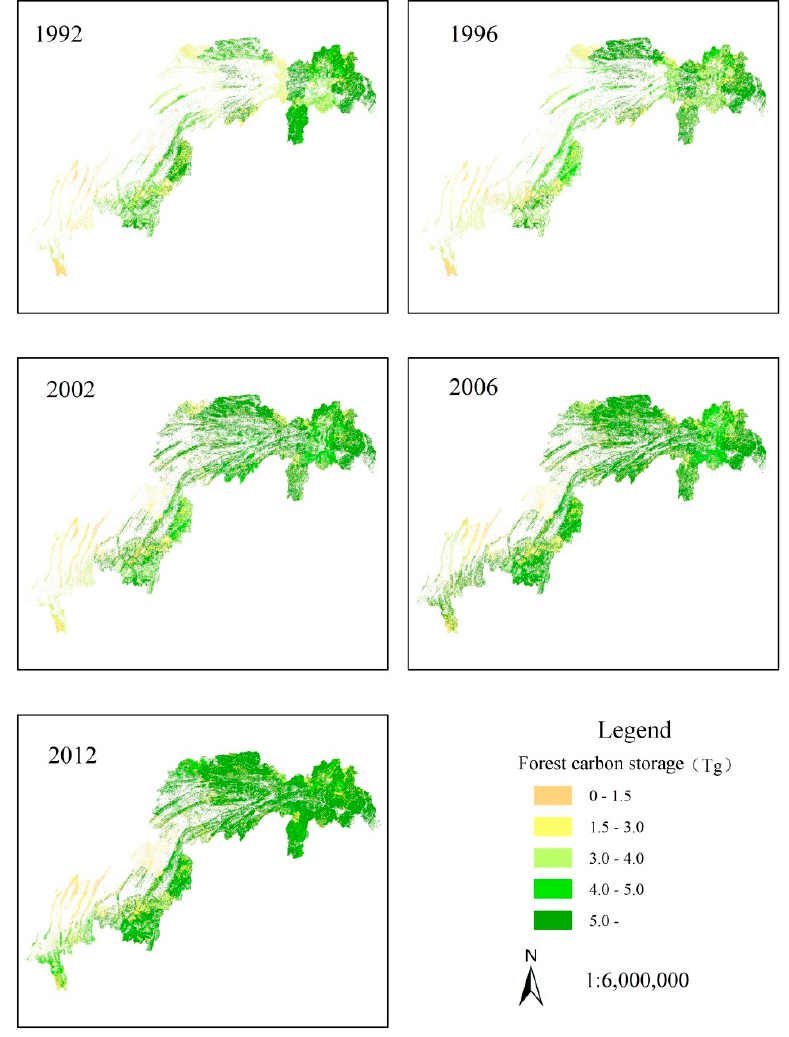
Figure 5. Spatial changes in forest carbon storage in the TGRA from 1992 to 2012.